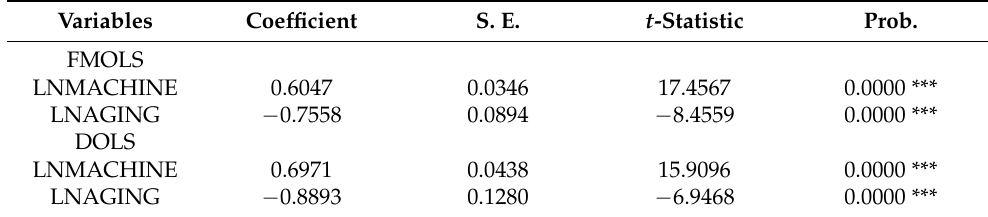
Table 7. Benchmark results.